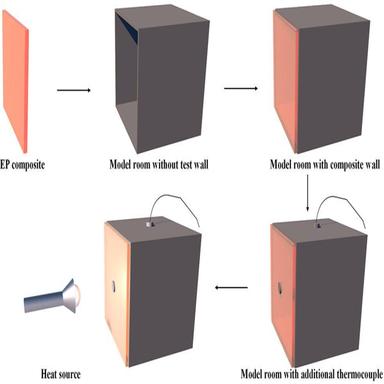
The mini-room model for testing the temperature controlling ability of the EP composites.